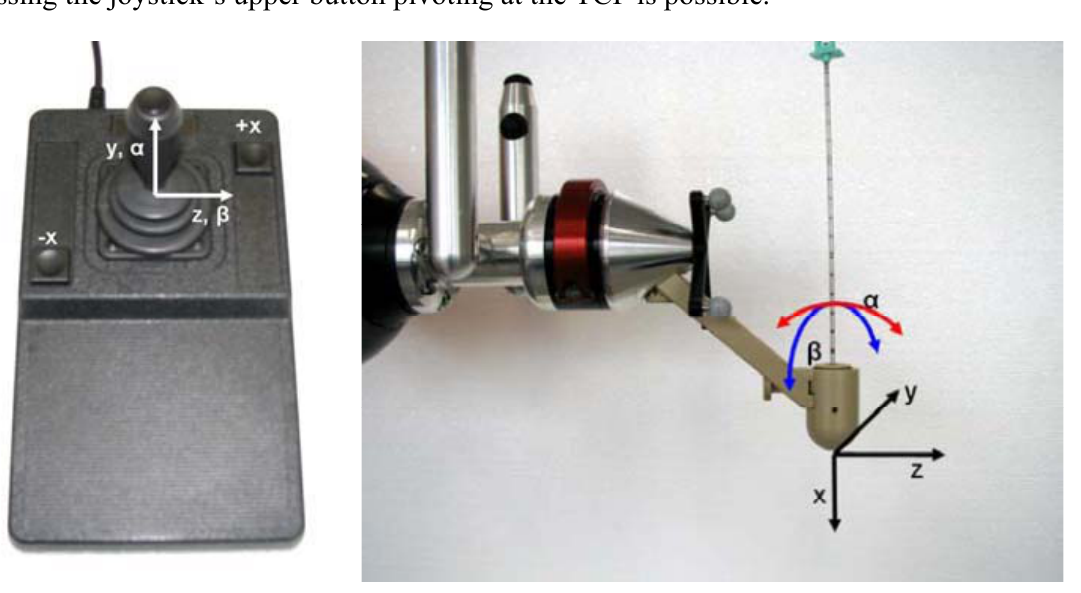
Figure 14. An industrial joystick is used to move the TCP in Cartesian coordinates. By pressing the joystick’s upper button pivoting at the TCP is